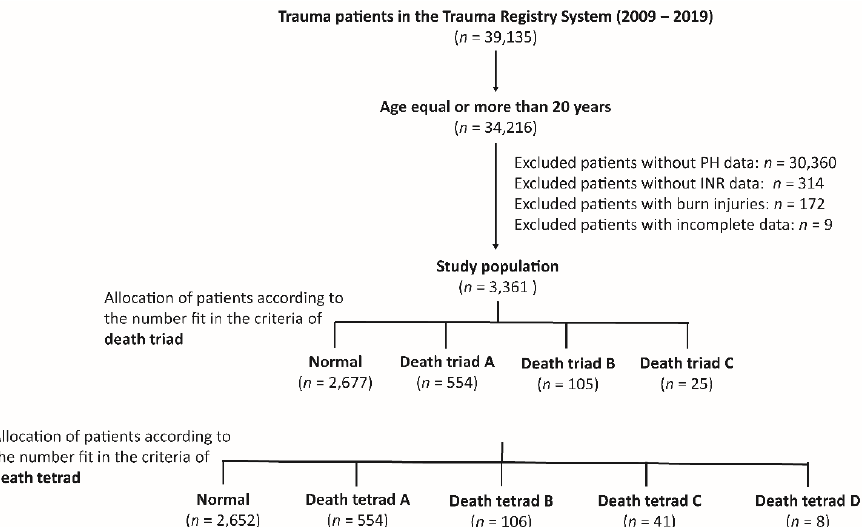
Figure 1. Flowchart illustrating the included hospitalized adult trauma patients from the registered trauma database, and the assignment of the study patient populations into three or four groups according to the number fit in the components of death triad or tetrad, respectively. In comparison with the death triad, the death tetrad has an additional component, hypotension, defined as systolic blood pressure < 60 mmHg. PH, potential of hydrogen; INR, international normalized ratio.